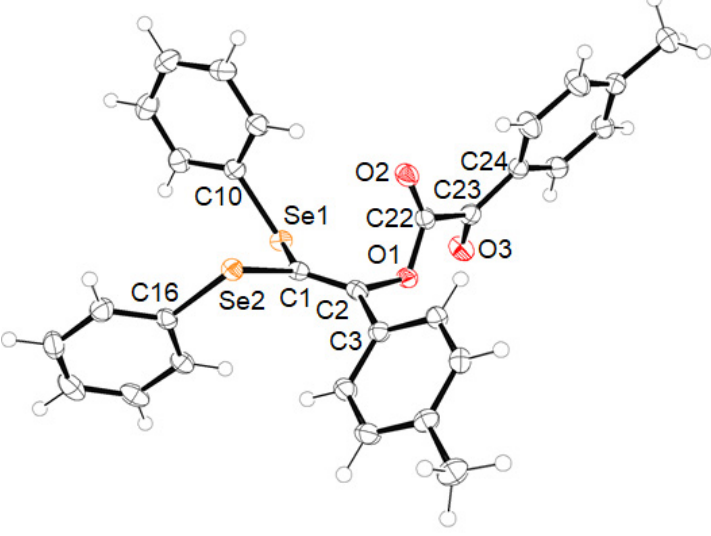
Figure 1. Crystal structure of 2a with numbered atoms. Ellipsoids are shown at the 50% probability level. Selected interatomic distances (Å) and angles (deg): Se1 − C1, 1.9178(17); Se1 − C10, 1.916(2); Se2 − C1, 1.9021(19); Se2 − C16, 1.9188(19); O1 − C2, 1.420(2); O1 − C22, 1.360(2); O2 − C22, 1.195(2);